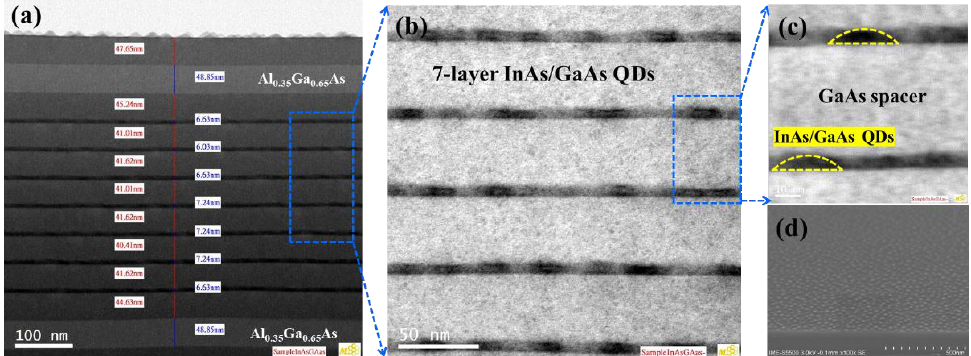
Figure 7. ( a ) Cross-sectional dark field HRTEM image of a defect-free seven-layer QD active region with Al 0.35 Ga 0.65 As cladding on both sides grown at 450 °C; ( b ) magnified image of InAs QDs; ( c ) Zoomed-in morphology of InAs QDs with a diameter of ~24 nm and height of ~7 nm; ( d ) Tilted- SEM image of the InAs QDs surface.